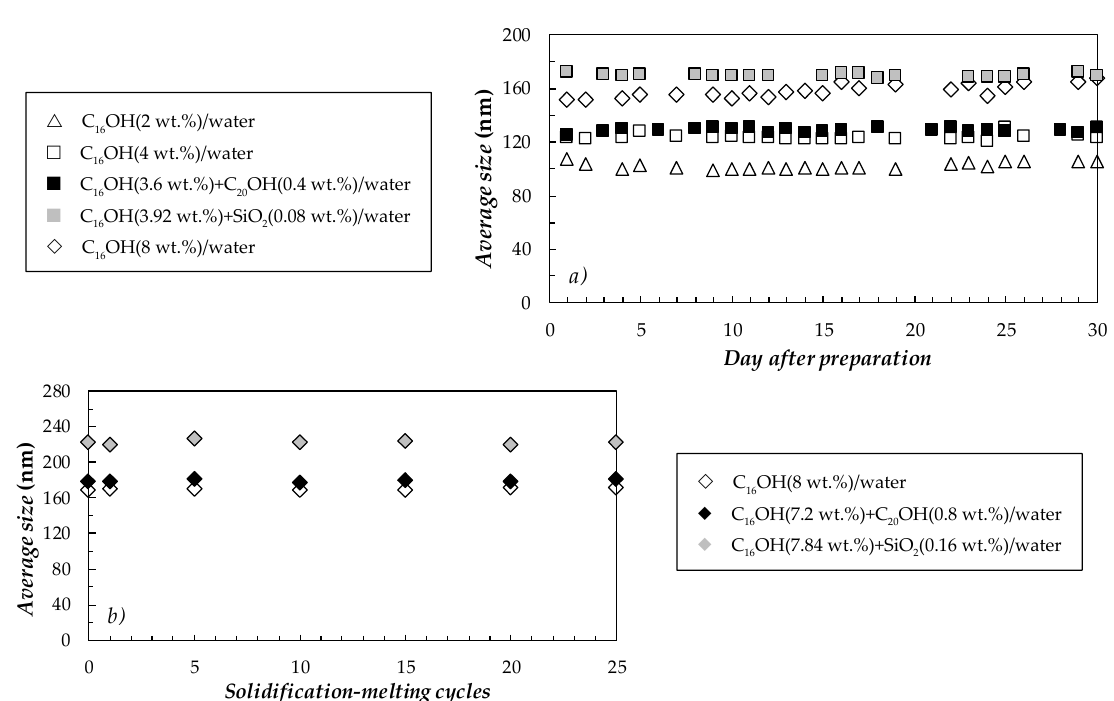
Figure 2. Evolution of the droplet average size: ( a ) throughout storage under static conditions and ( b ) after solidification–melting cycles for some representative emulsions.